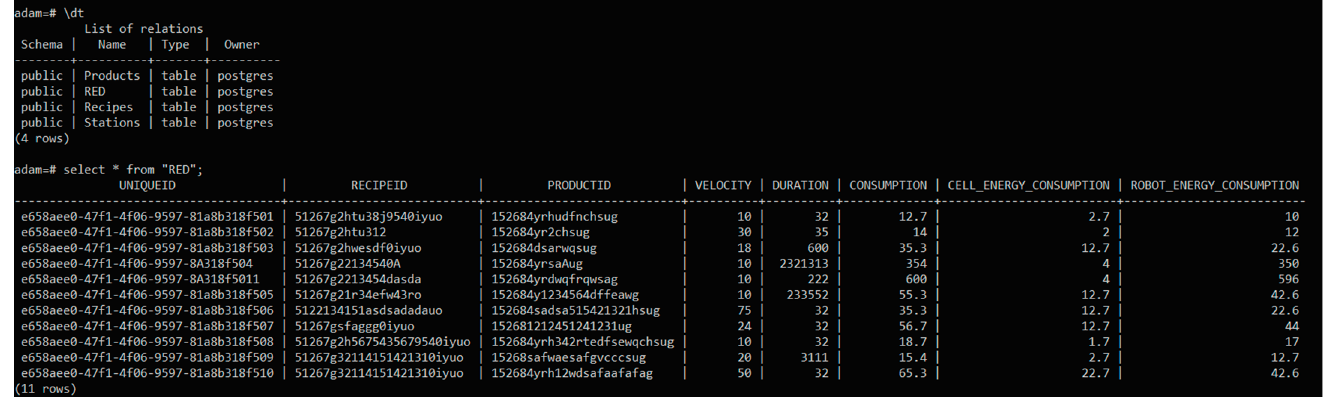
Figure 12. Database structure and sample of stored data.